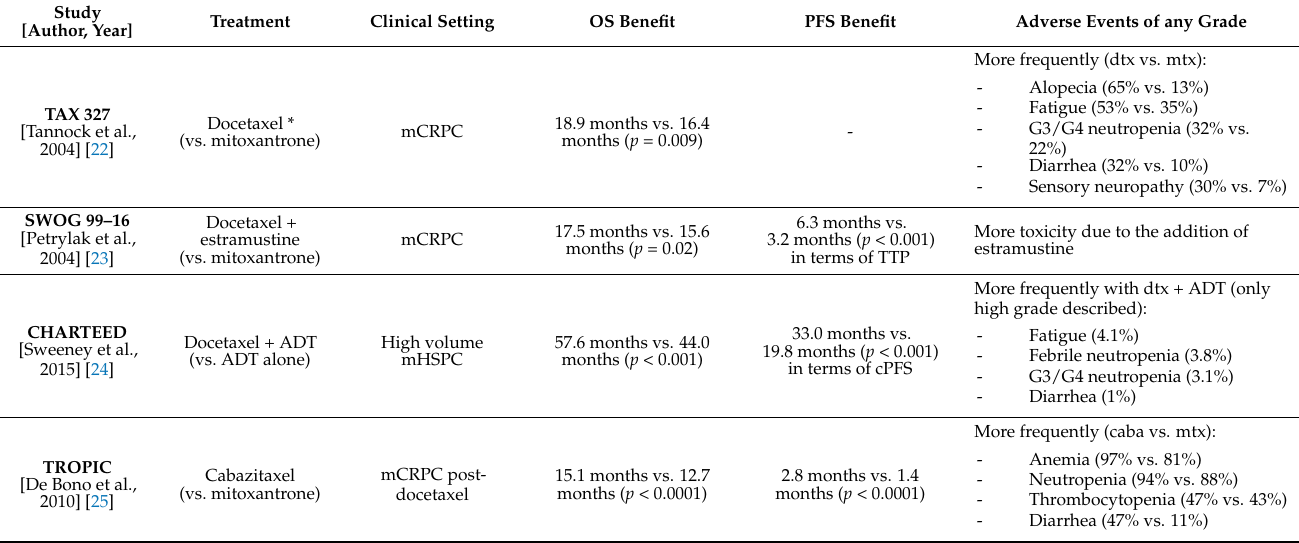
Table 2. Pivotal phase III trials published from 2004 to 2020 that have radically changed the therapeutic scenario of metastatic prostate cancer, both in hormone-sensitive and castration-resistant